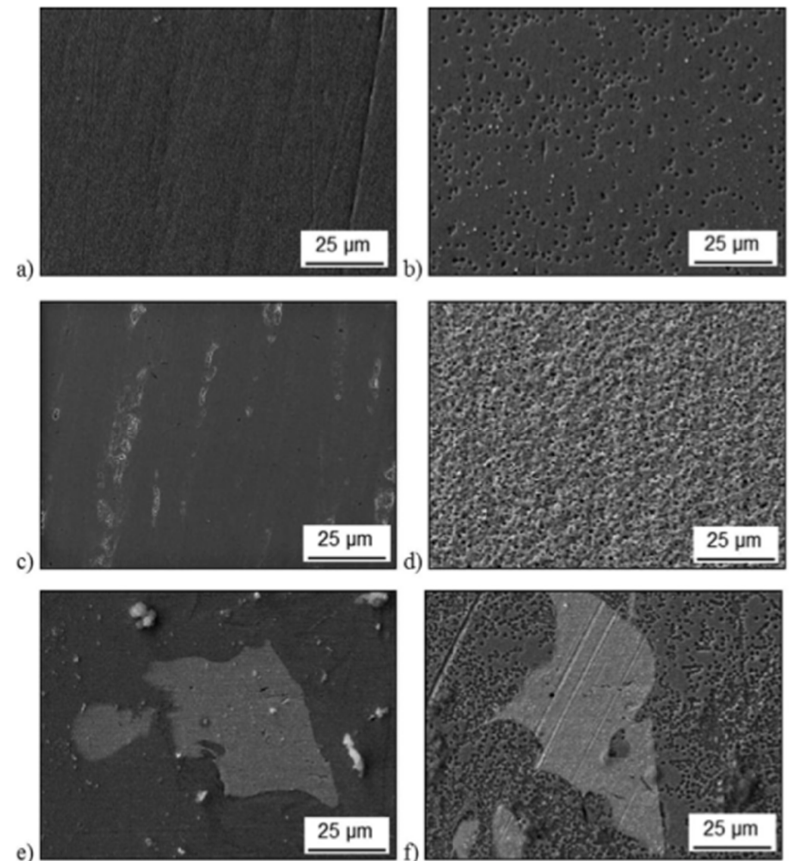
Figure 8. SEM images of ( a , b ) the FeMn sample; ( c , d ) the pure Ag sample; and ( e , f ) the FeMn-Ag sample before (left) and after (right) EIS [57].